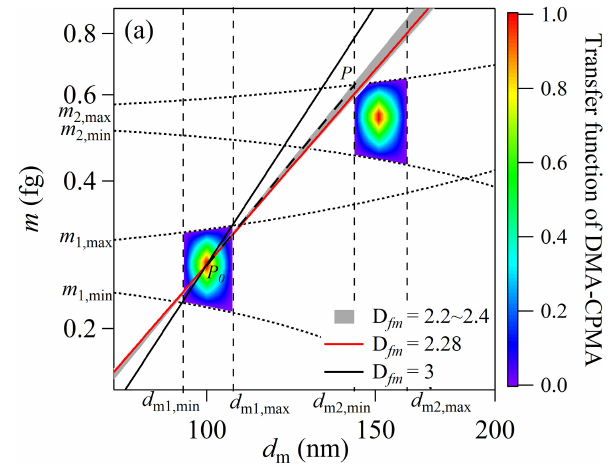
Figure 2. Example of the DMA–CPMA transfer function of flame- generated soot particles (Pei et al., 2018) in log( m) –log( d m ) . The following parameter set was employed for the calculations: d m = 100nm, β DMA = 0 . 1, m = 0 . 33fg, Q CPMA = 0 . 3L min − 1 and R m = 8. The color blocks are the transfer function of DMA– CPMA, with the rainbow color representing the transfer function for singly charged (lower left block) and doubly charged (upper right block) particles. The solid black and red lines are particle popula- tions with D fm values of 3 and 2.28, respectively. The gray region is the particle population with D fm of 2.2–2.4, which is typical for soot aerosols. The dotted lines are the limits of d m and m of the DMA and CPMA, respectively. The dashed line is the critical slope of PP 0 . The DMA–CPMA transfer function for + 2 particles does not overlap with the line for spherical particles with a single charge ( D fm = 3).